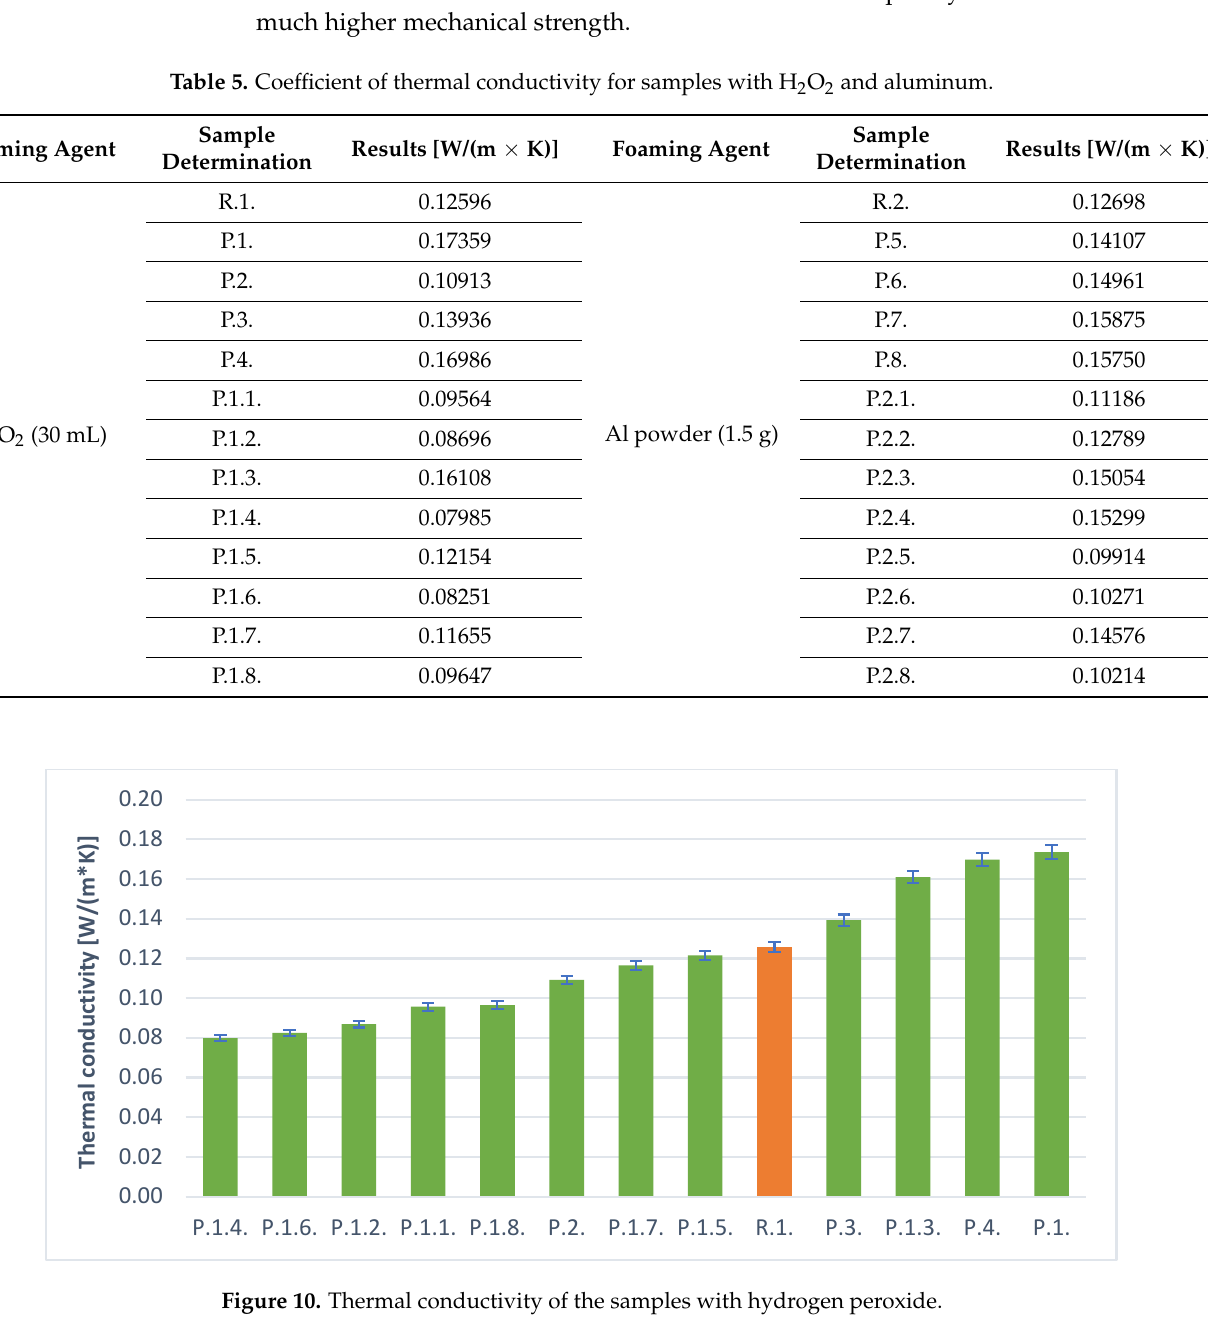
Figure 11. Thermal conductivity of the samples with aluminum. As a result of the tests, it was observed that better results were obtained for samples of foamed H 2 O 2 than in the case of aluminum powder. This is also consistent with the density studies. Better insulation parameters were obtained for samples with lower den- sity. The addition of surfactants had a beneficial effect on reducing density and improving thermal conductivity. It should be noted that both hydraulic additives such as cement or gypsum have a positive effect on the stability of the geopolymer foams produced, but also the addition of surfactants has a positive effect. The combination of these two additives gives the best results. The samples without the addition of surfactants, but only with hy- draulic stabilizers, performed worse. The best thermal conductivity values were obtained for samples foamed with H 2 O 2 and this was the case in several cases (P.1.2; P.1.4; P.1.6). These samples also had the lowest density of all the materials obtained. They were all obtained for the stabilizer, which was cement. It should be concluded that this is a better type of hydraulic additive than gyp- sum. Based on the results obtained, it can be assumed that the best solution for obtaining the best possible insulation materials from foamed geopolymers is the use of H 2 O 2 to- gether with cement and surfactants. However, the obtained values of thermal conductiv- ity coefficient of 0.08 [W/m × K] are not sufficient for this material to compete with com- monly used insulation materials. It is expected that the use of higher amounts of H 2 O 2 will give better results in terms of thermal conductivity coefficient values.